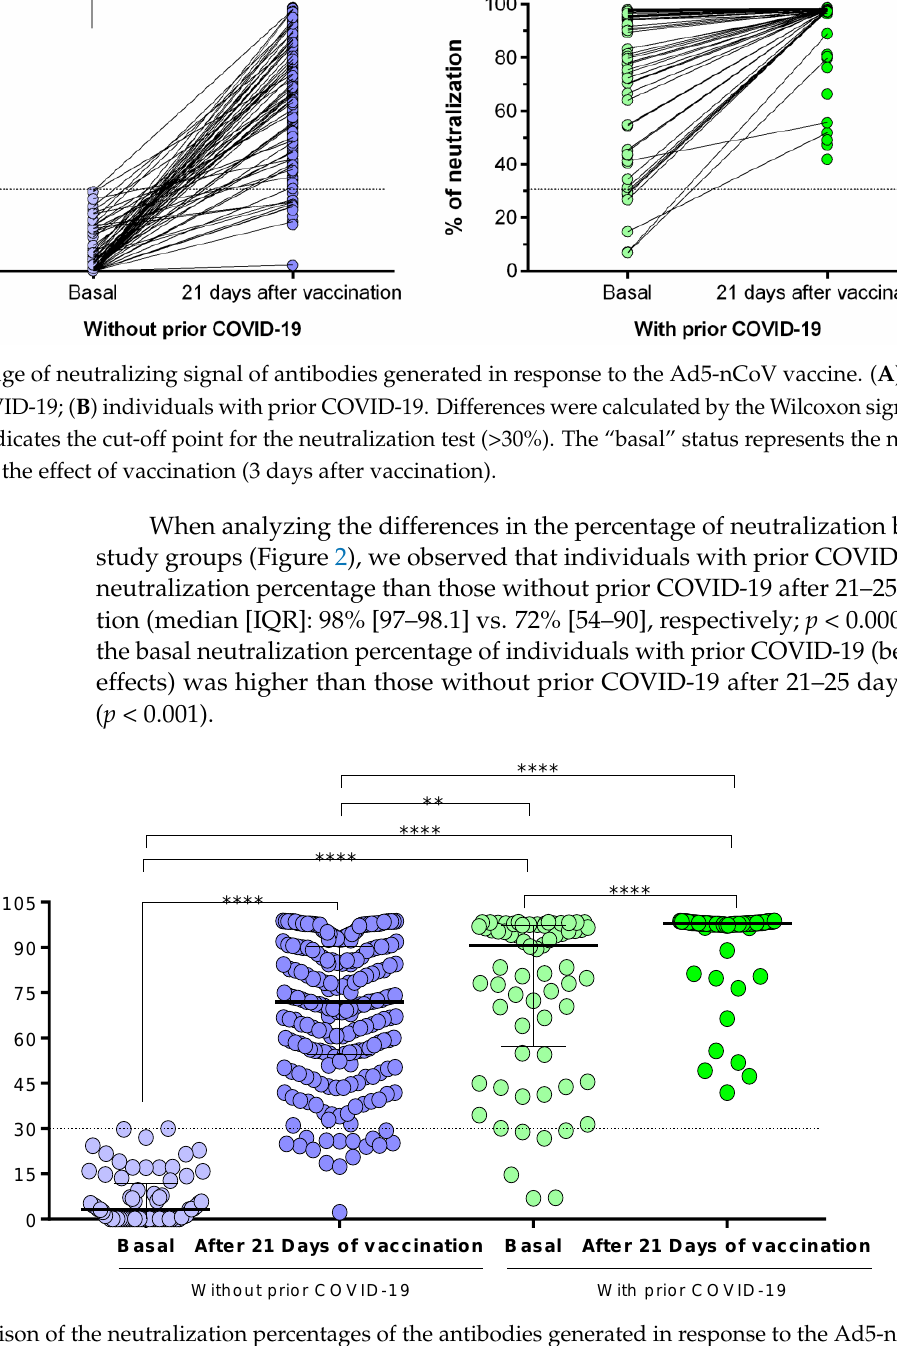
Figure 2. Comparison of the neutralization percentages of the antibodies generated in response to the Ad5-nCoV vaccine. The difference between all groups was calculated with the U-Mann–Whitney test or the Wilcoxon signed-rank test. The data are provided as medians and interquartile ranges. ****, p < 0.0001; **, p < 0.001.